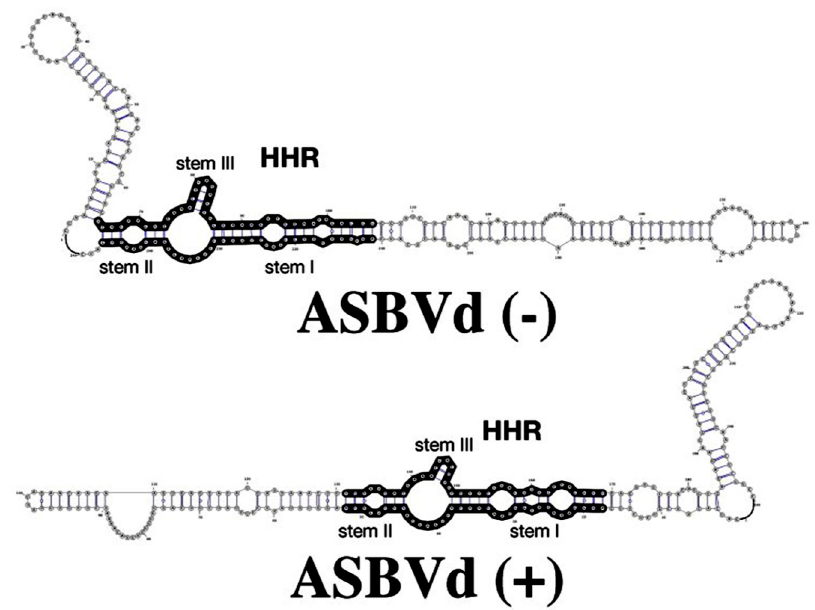
Figure 1. RNA 2D structures of the avocado sunblotch viroid (ABSVd(–)) and ASBVd(+) (top and bottom, respectively). The full-length genome of ASBVd can fold into 2D structures that preserve the hammerhead ribozyme (HHR) motif (regions in black) in both the (–) and (+) strands; the HHR motif of ASBVd(–) is more stable, with 3 base-pairs in stem III but only two base-pairs in ASBVd(+). (Reprinted with permission from ref. [22]. Copyright 2019 Marie-Christine Maurel).